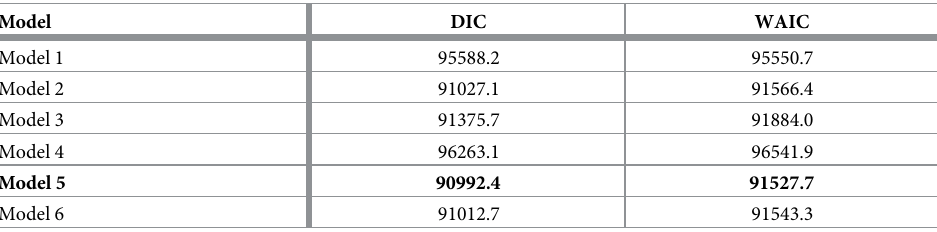
Table 3. Estimation results: DIC and